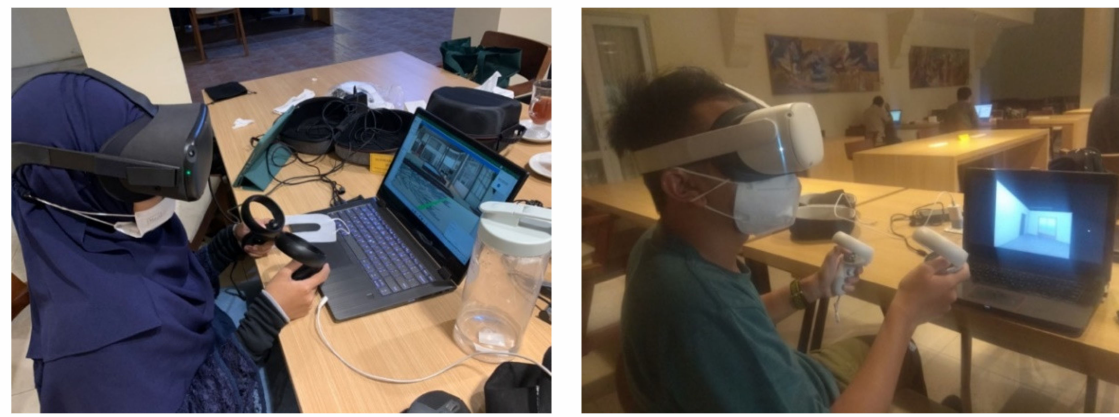
Figure 7. Part 2 simulation in progress (Photo credit: